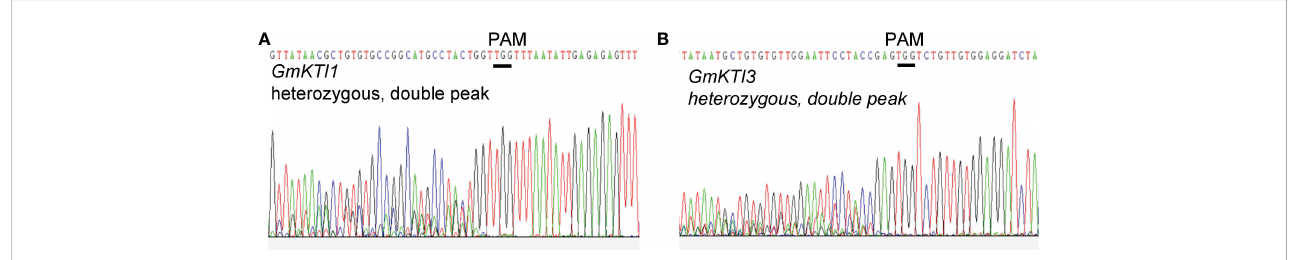
FIGURE 5 Sanger sequencing chromatograms display the DNA sequence of GmKTI1 and GmKTI3 that is targeted for gene editing. The open reading frames of GmKTI1 and GmKTI3 in the pCas9-GmKTI1/GmKTI3 gRNA T0 transgenic soybean plants were ampli fi ed and sequenced. The double peaks in the sequencing chromatograms indicate the presence of both wild-type and mutant allele of sequences GmKTI1 (A) and GmKTI3 (B) . The wild-type gene sequences are shown on the top of the sequencing chromatograms. The PAM sites are